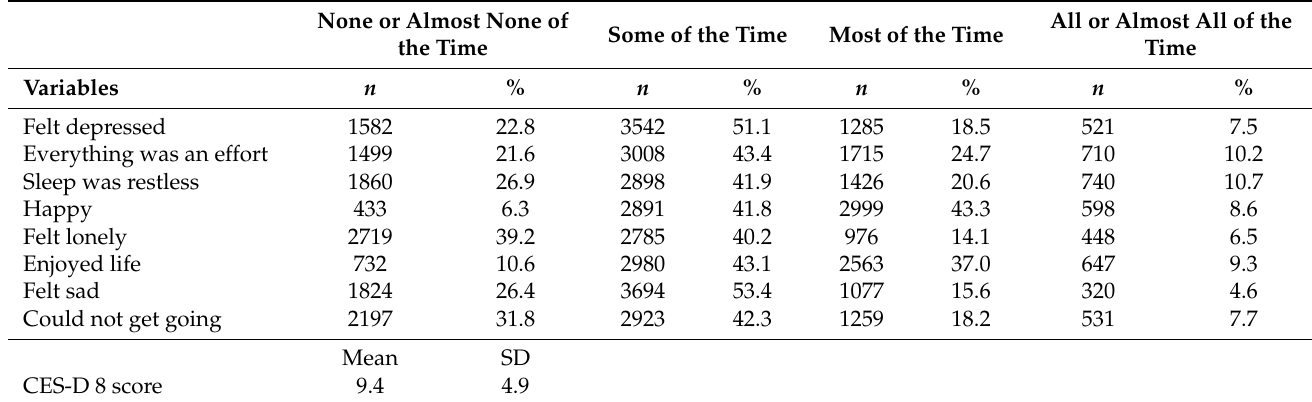
Table 2. Depressive symptoms assessed with the CES-D 8 ( n = 6848).